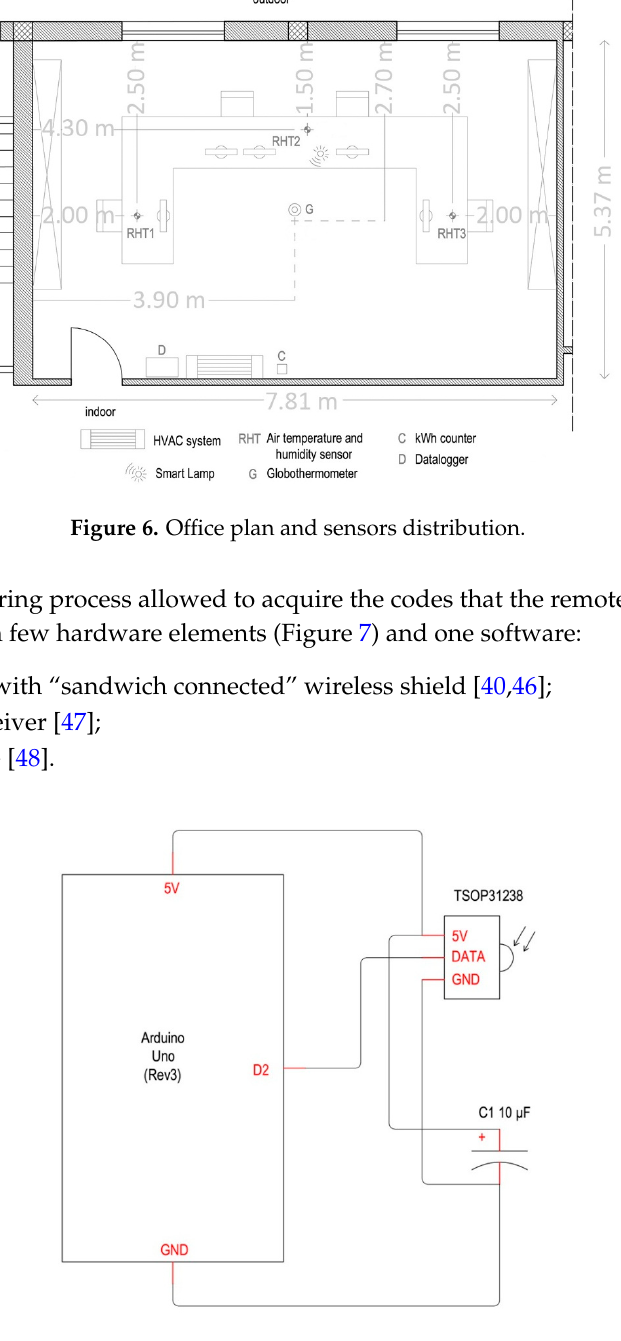
Figure 7. IR signals acquisition system: wiring diagram.